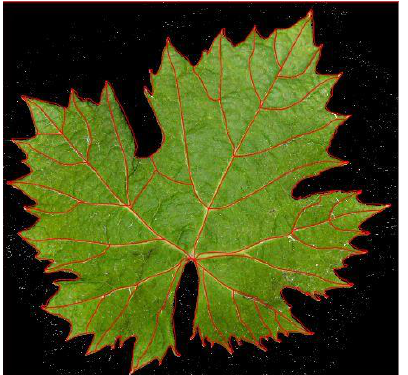
Figure 17. CAD image superimposed over an orthophoto